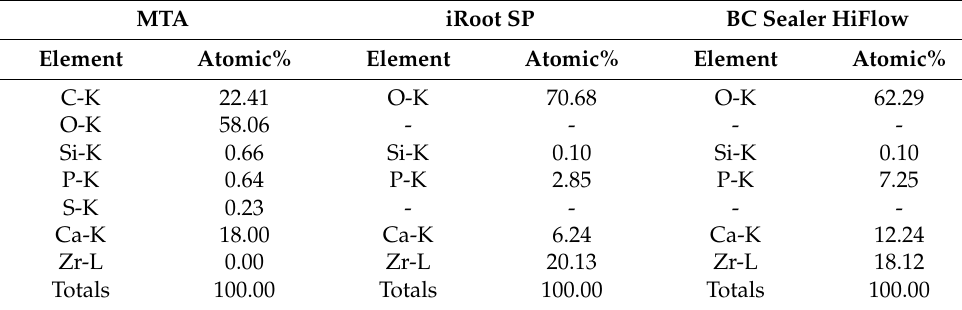
Figure 1. Analysis of in vivo surface characteristics of dentine tube biomaterials. SEM micrographs of ProRoot MTA ( a1 – a4 ); iRoot SP ( b1 – b4 ); EndoSequence BC Sealer HiFlow ( c1 – c4 ) at 4 magnifications (1000×, 2000×, 5000×, and 10,000×). ( d ) EDX spectrum of ProRoot MTA, iRoot SP and BC Sealer HiFlow. Table 2. EDX analysis of MTA, iRoot SP and BC Sealer HiFlow.